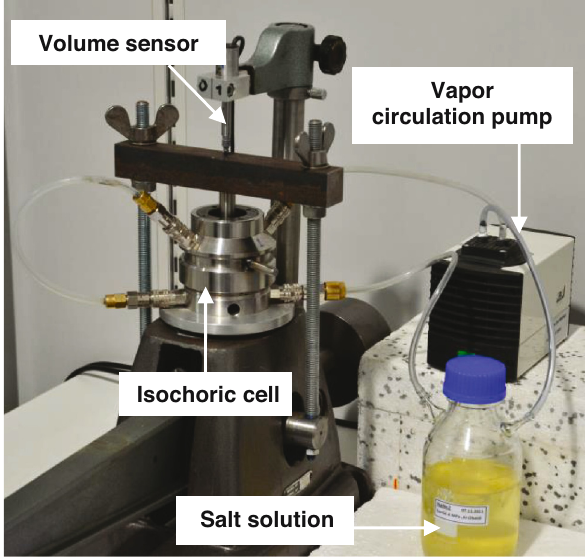
Figure 2: Modi fi ed - Isochoric Oedometer cell with the VET.